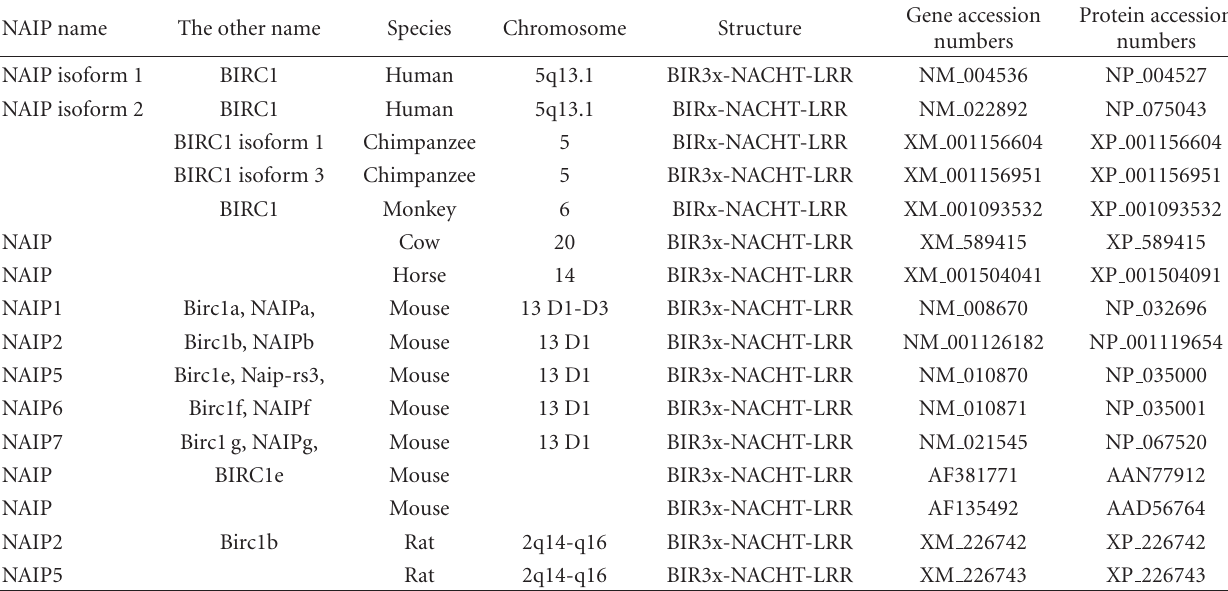
Table 1: The sequences used in this study.